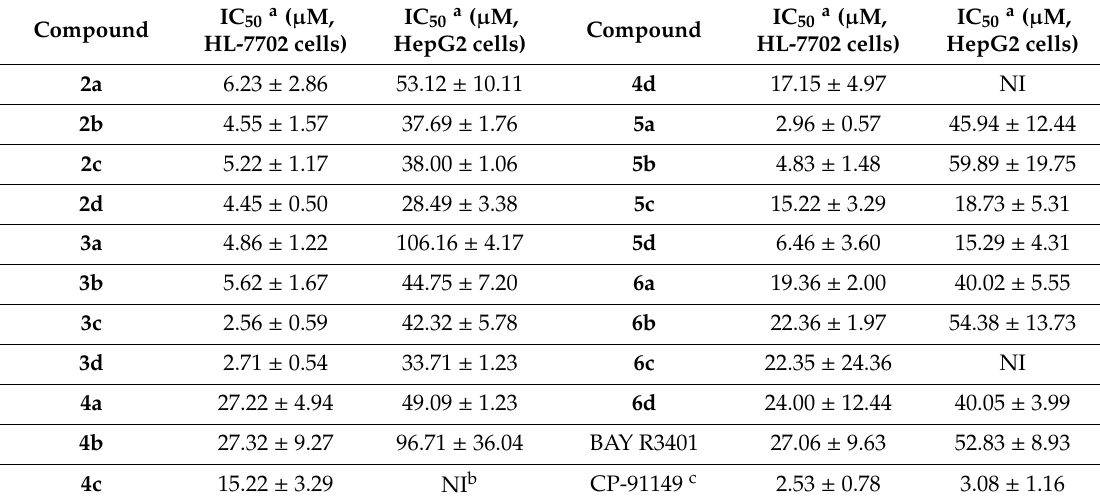
Table 1. Glycogenolysis inhibition assay for compounds 2(a – d) – 6(a – d) in liver